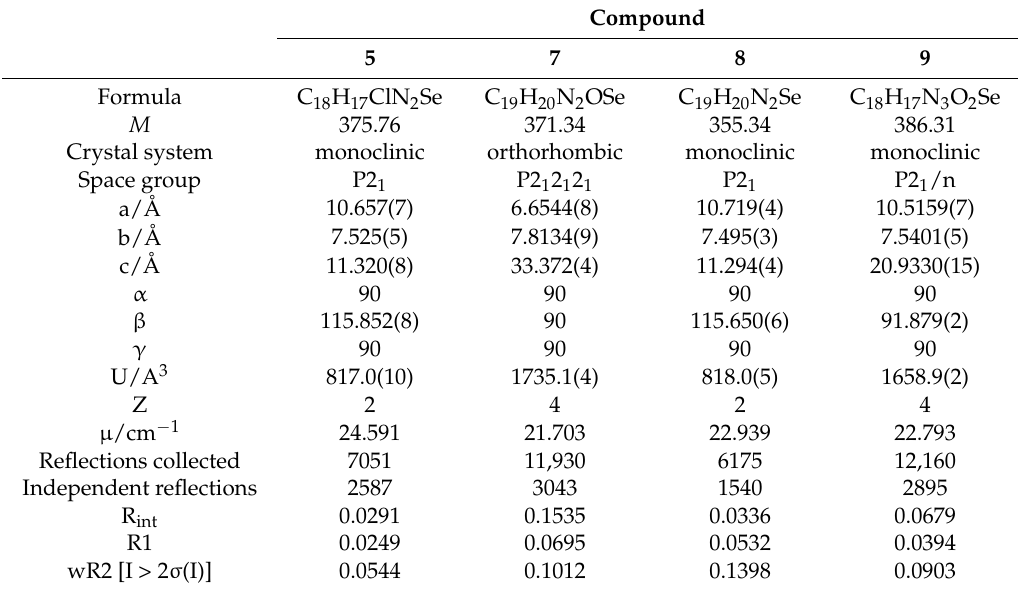
Table 2. Details of the X-ray Data Collections and Refinements for Compounds 5 , 7 , 8 and 9 .